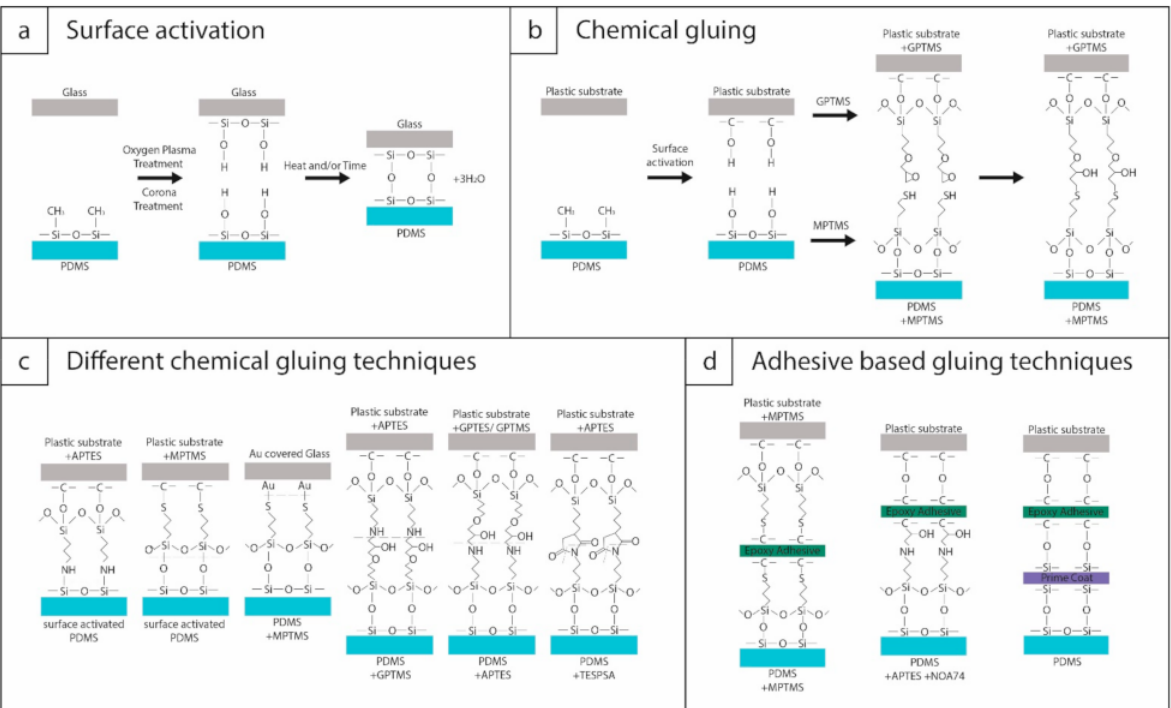
Figure 2. Illustrations of the process steps of ( a ) surface activation with oxygen plasma or corona treatment, ( b ) chemical gluing. ( c ) The most often used chemical gluing methods. ( d ) Adhesive-based or combined gluing